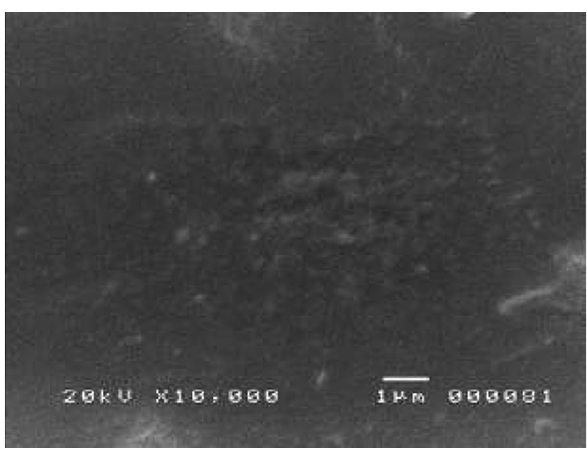
Figure 14. SEM micrograph of the bare SPGE at ×10,00 magnification.